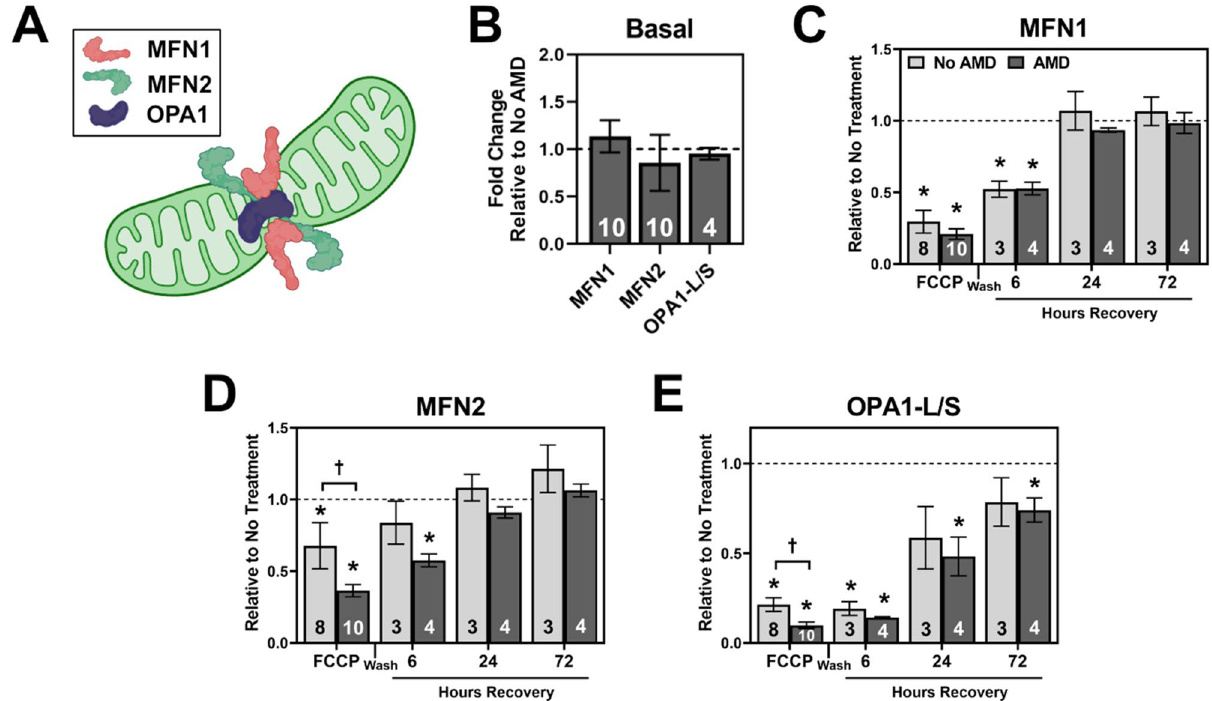
Figure 4. Response of Mitochondrial Fusion Machinery to FCCP stress and recovery. ( A ) Schematic of mitochondrial fusion. Healthy mitochondria (green) fuse the outer mitochondrial membranes via mitofusin-1 (MFN1), mitofusin-2 (MFN2), and the inner mitochondrial membrane via dynamin-like 120 kDa protein (OPA1). ( B ) Basal content of fusion proteins in AMD RPE relative to No AMD RPE. ( C – E ) Quantification of fusion proteins MFN1 ( C ), MFN2 ( D ), OPA1-L/S ( E ) after 4 h FCCP and recovery time points. All data shown is mean ± SEM. Number of samples for each experiment is provided in the bars. * denotes significance ( p < 0.05) from no treatment controls (dashed line). † denotes significance ( p < 0.05) between No AMD and AMD RPE. Panel A produced in